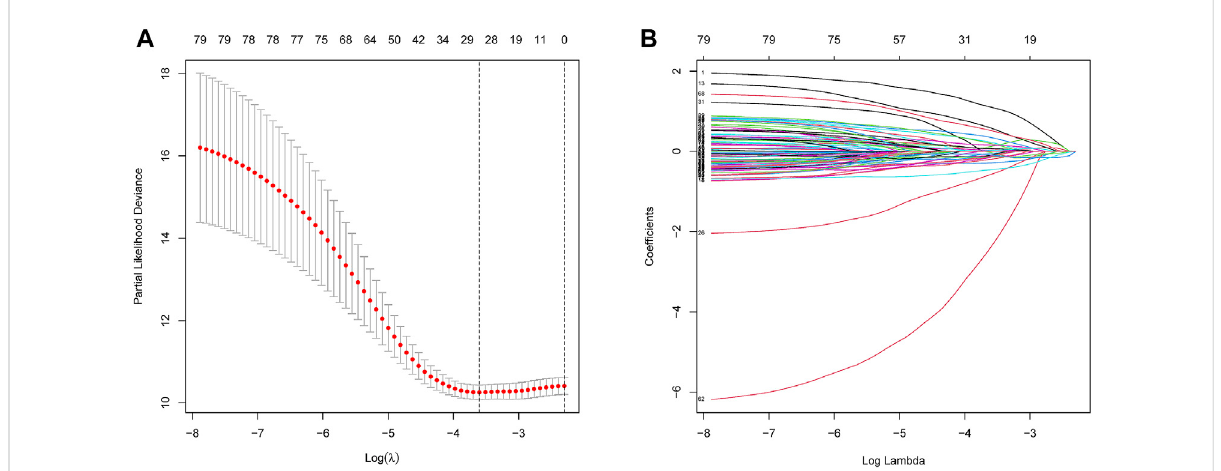
FIGURE 2 Construction of the RNA processing factors related risk signature model. (A,B) Partial likelihood deviance of variables revealed by the Lasso regression model. The red dots represented the partial likelihood of deviance values, the gray lines represented the standard error (SE), the two vertical dotted lines on the left and right represented optimal values by minimum criteria and 1-SE criteria, respectively.